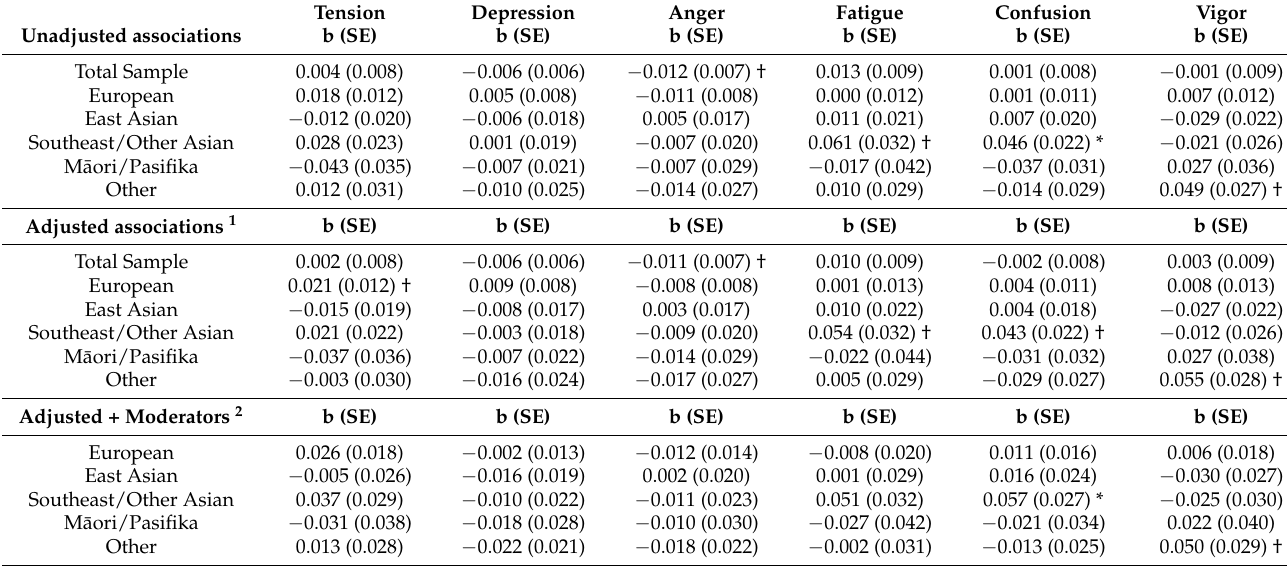
Table 4. Associations between Vitamin C and the Profile of Mood Scale (POMS) subscales for the Total Sample and for Different Ethnicity Groups, Unadjusted for Covariates (top), and Adjusted for Covariates (middle) and Adjusted for Covariates and Moderators